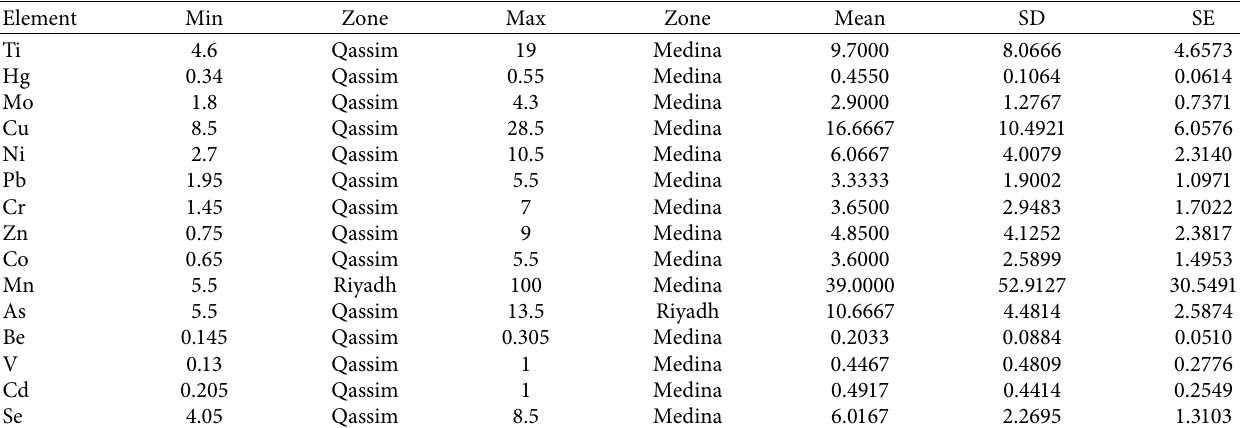
Table 3: Results of the soil contaminated with heavy metals at wastewater of Riyadh, Qassim, and Medina regions.